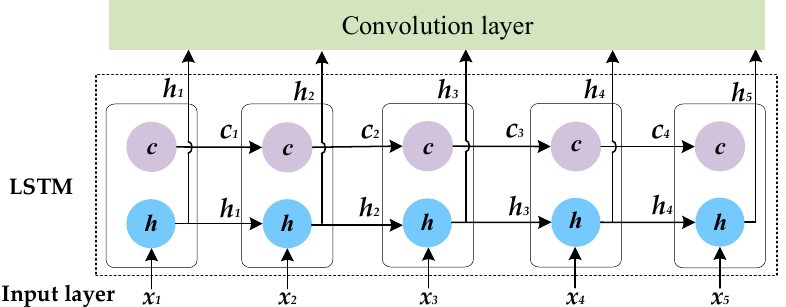
Figure 6. Long short-term memory, input layer, and convolution layer connection.